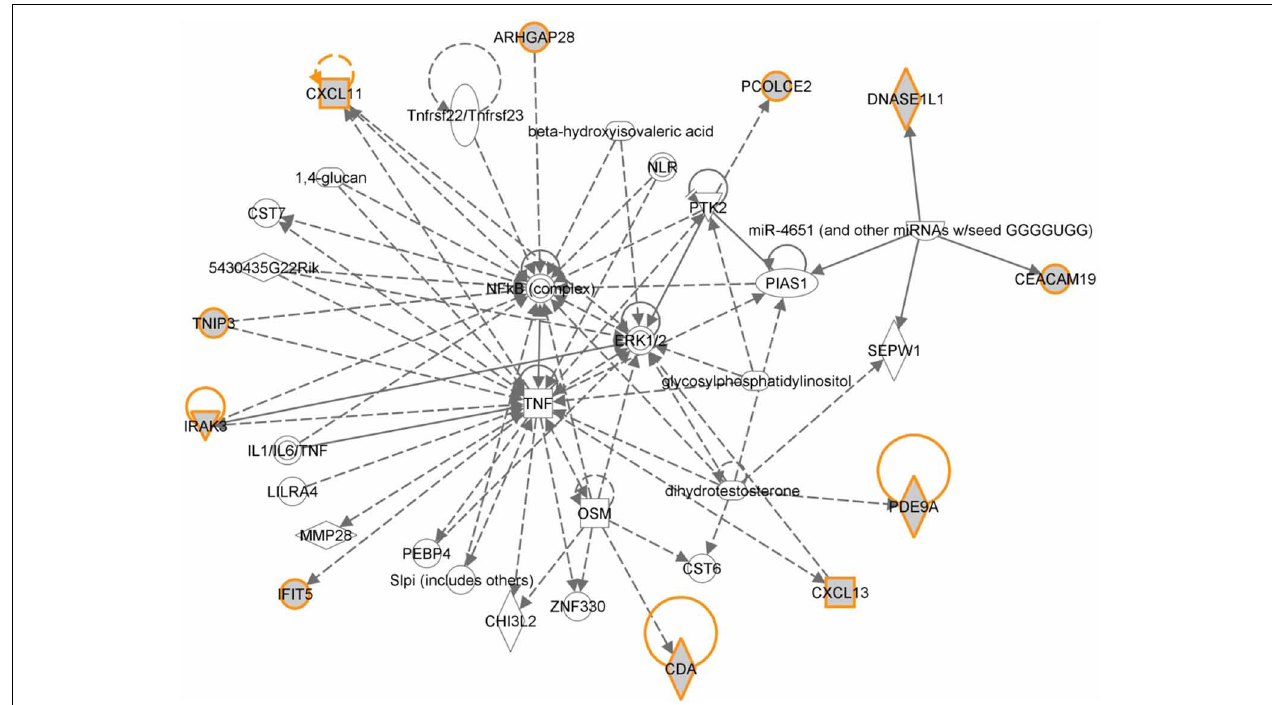
FIGURE 3 | Gene network shown for the short list of selected genes in Table 2. Genes in the short list are shown with yellow outline. Direct downstream interactions include TNF, NFkB, and ERK1/2.